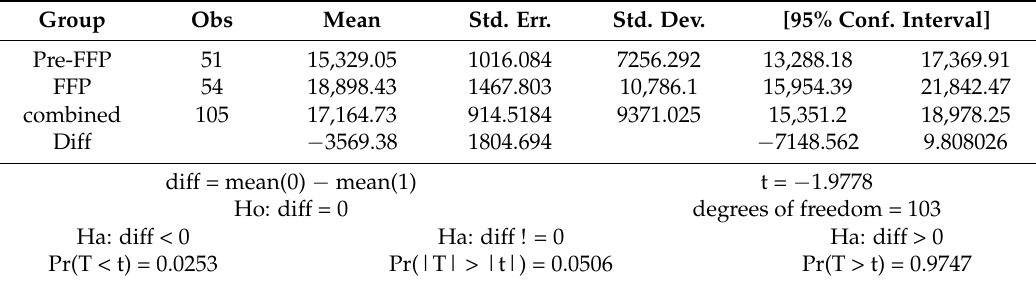
Table 4. Two-sample t-test with equal variances (pre-FFP vs. FFP). Group Obs Mean Std.